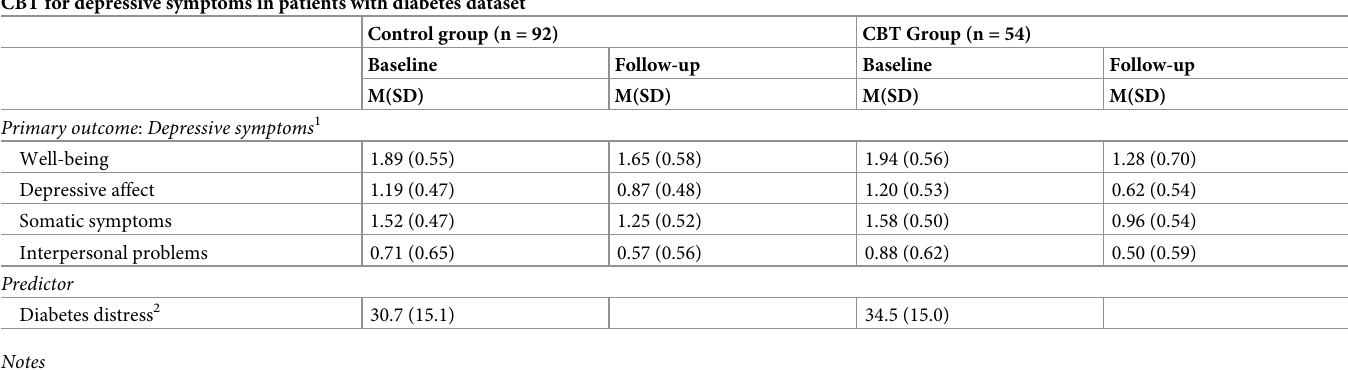
Objective 2. The detected response shift had a moderate impact on the change in item 2, where the observed reduction in this item score was larger than what would have been expected if the item response scale was equivalent as compared to baseline (response shift effect, Cohen’s d = -0.75; see also S1 Table in S1 Appendix). The decrease in insomnia severity in the CBT group was somewhat smaller when taking into account response shift ( d = -1.75) as compared to when response shift was not taken into account ( d = -1.92). Hence, other than expected, taking into account response shift only slightly reduced the overall treatment effect. Objective 3. Anxiety and sleep-efficiency showed small but significant associations with the detected recalibration response shift ( r = -.18, p = .047; r = -.22, p = .009), indicating that more anxiety and better sleep-efficiency are associated with more recalibration response shift in item 2. That is, patients who score higher on anxiety and sleep-efficiency at baseline tend to more easily indicate less problems with difficulty staying asleep at follow-up. There were no significant effects of age or the type of trial (i.e., the insomnia trial versus the insomnia and depression trial).